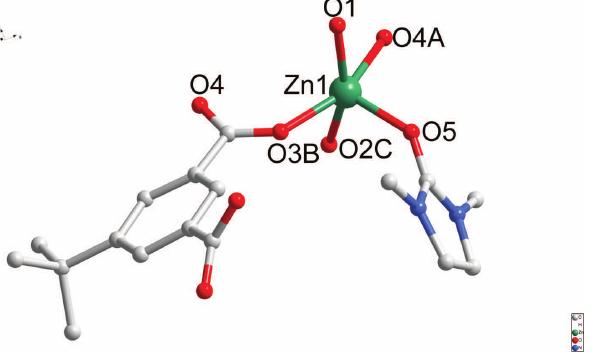
Table 1: Data collection and